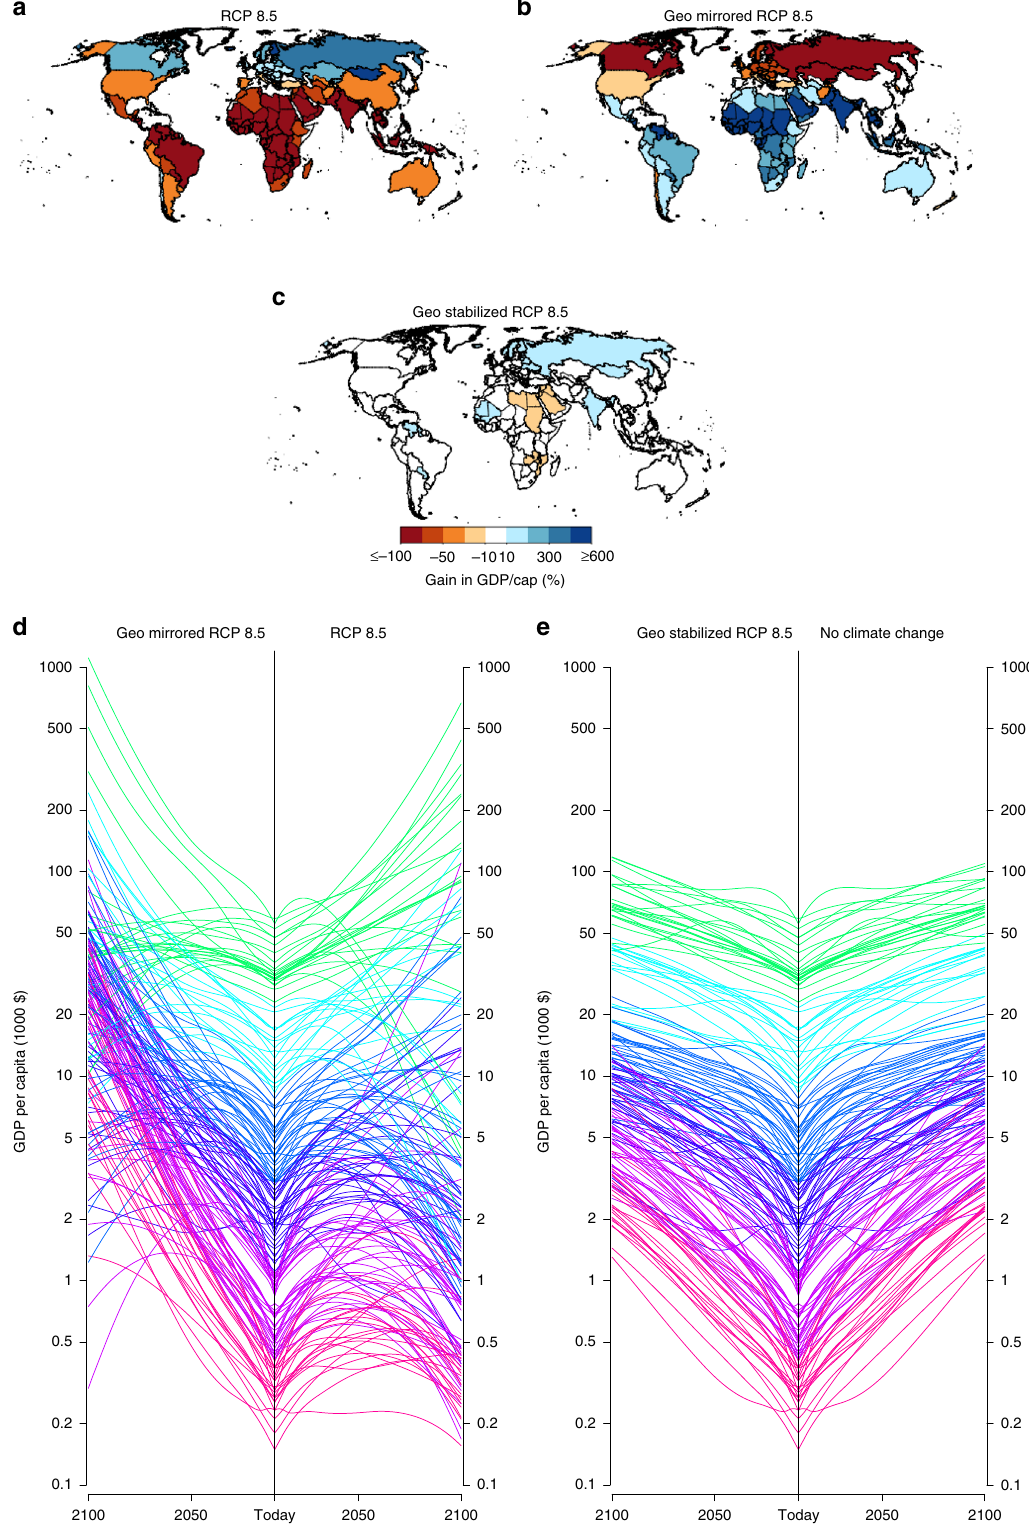
Fig. 2 County-level income projections over the 21st century with and without solar geoengineering. Results are estimated using the model in column (1) of Supplementary Table 1 and Supplementary Table S1 for Shared Socioeconomic Pathway (SSP_ 3. Projected percent gain in GDP per capita by 2100 relative to no climate changes for: a Geoengineering-mirrored RCP8.5, b RCP8.5, and c Geoengineering-stabilized RCP8.5 scenario. d the transient evolution of GDP per capita for each country over time under geoengineering-mirrored RCP8.5 and RCP8.5, as well as e the Geoengineering-stabilized RCP8.5 and SSP3 without climate change. Each line represents a speci fi c country with color representing the country ’ s initial GDP per capita in 2010. See Supplementary Materials for other SSPs, climate-economy model speci fi cations (Supplementary Figs. 3 and